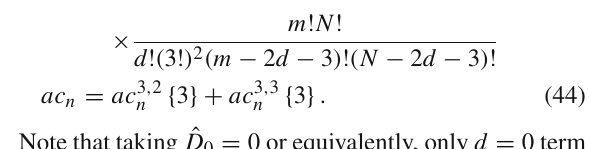
Fig. 11 Thedependenceofthemaximumvalueof ac 4 (asafunctionof momenta) on multiplicity m for different values of ¯ m where ˆ D 0 = 0 . 1 and N c = 3